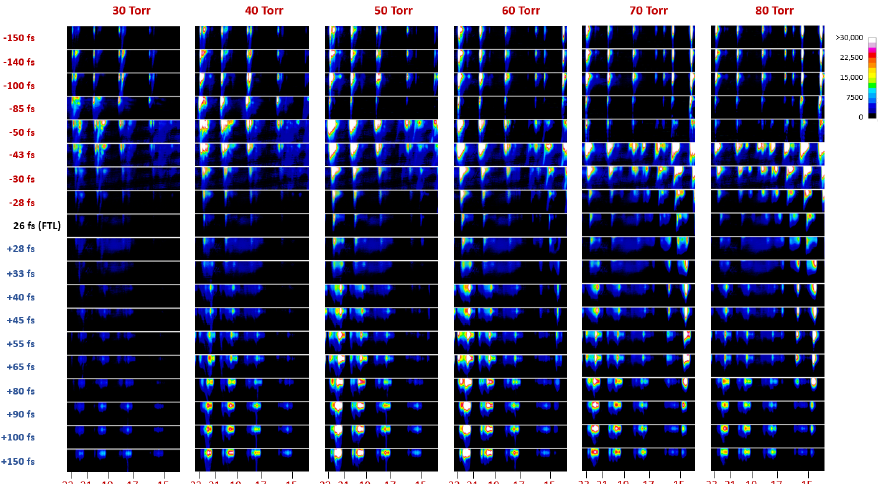
Figure 4. XUV harmonic spectral images measured for various laser pulse durations and Ar gas pres- sures. The negative/positive signs of the laser pulse durations correspond to the negative/positive chirp, respectively. The nominal spectral locations of the harmonics order, estimated by ray-tracing calculations, are noted at the bottom of the XUV spectral images.